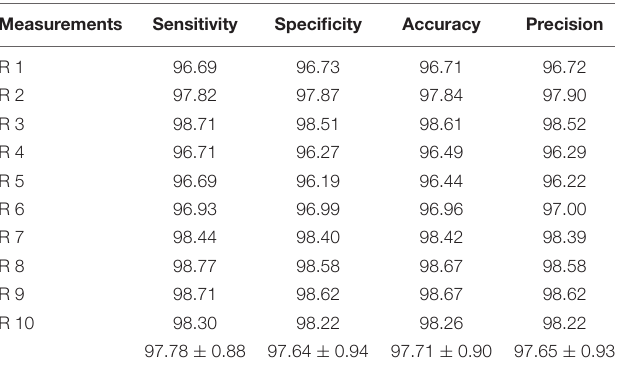
TABLE 4 | Comparison of different cases of transfer learning (Unit: %). Sensitivity